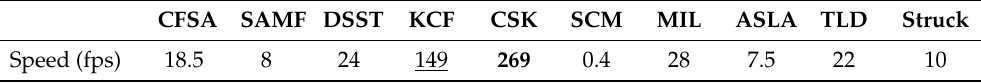
Table 5. The running speed of CFSA and other state-of-the-art trackers on OOTB benchmark dataset. Bold and underline values indicate best and second running speed, respectively. fps: frames per second. CFSA SAMF DSST KCF CSK